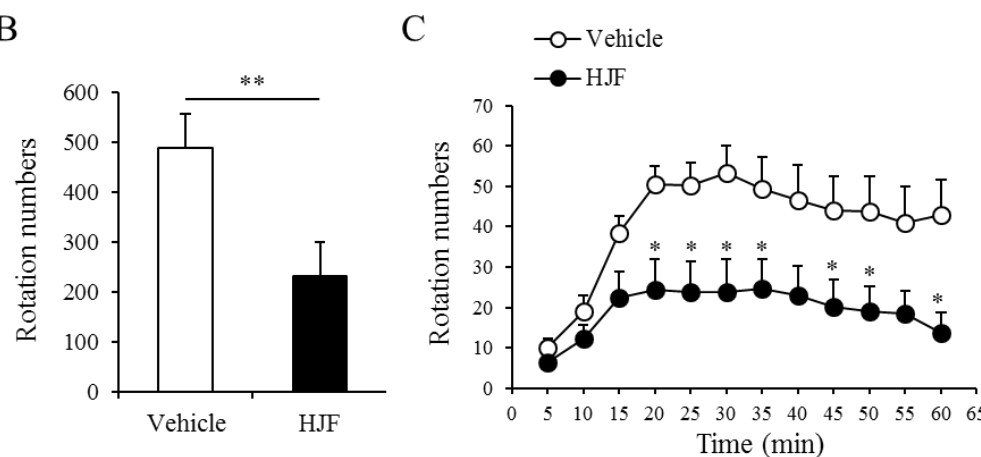
Figure 5. Oral administration of HJF improves forelimb-use asymmetry and d-AMPH-induced